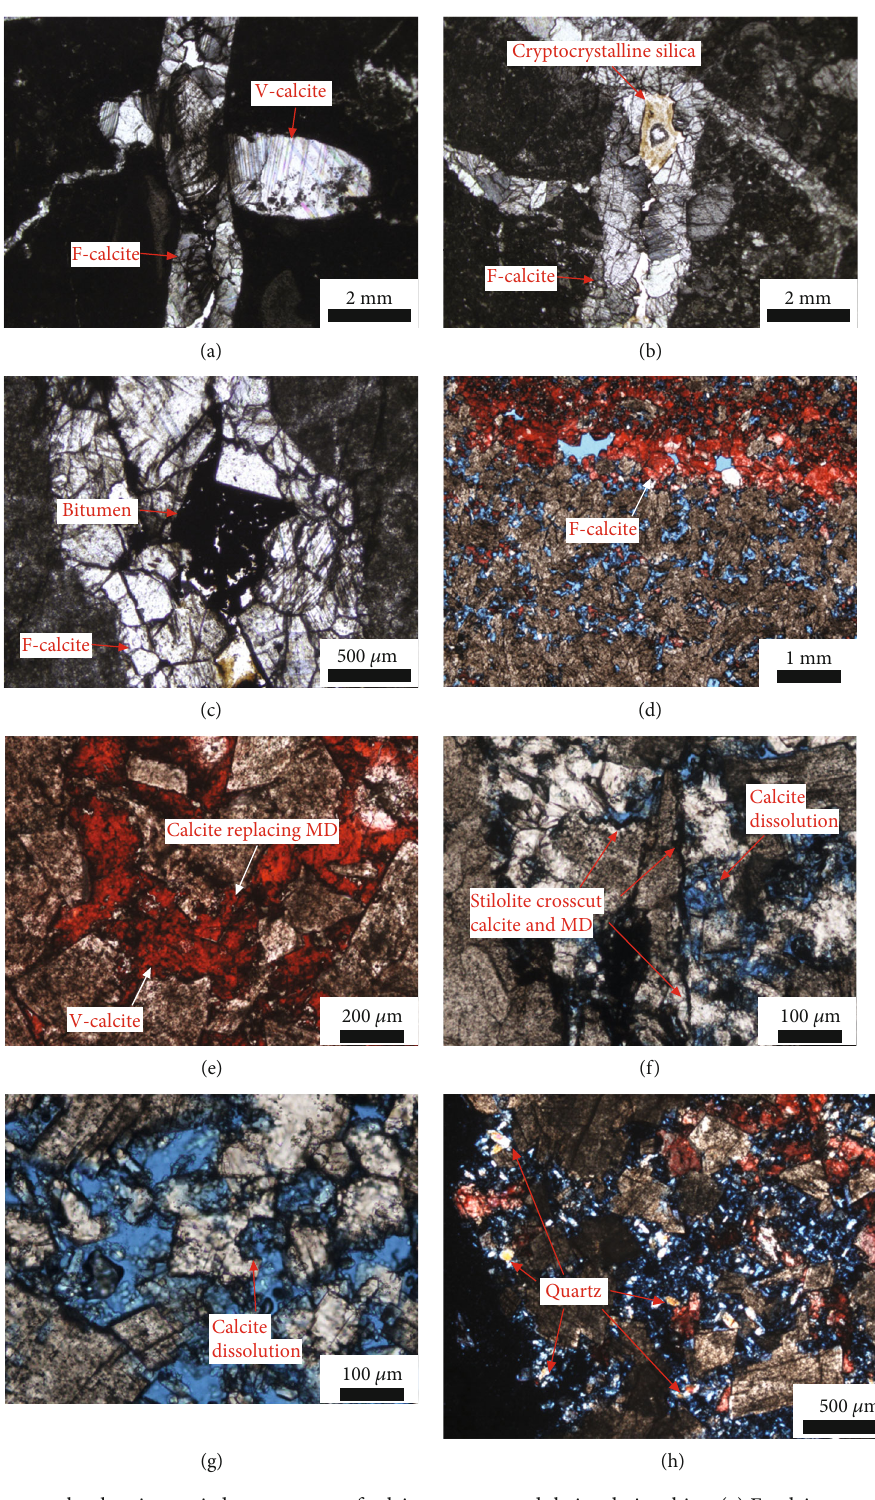
Figure 3: Photomicrographs showing varied occurrences of calcite cements and their relationships. (a) F-calcite crosscutting v-calcite; plane yj ). (b) Cryptocrystalline silica fi lling the rest space left by f-calcite; plane polarized light (SHB5-8-3; polarized light (SHB5-8-1; 7678.6m; O 2 7679.3m; O yj ). (c) Bitumen fi lling the rest space left by f-calcite; plane polarized light (SHB5-8-1; 7679.3m; O yj ). (d) F-calcite and medium- 2 2 crystalline, planar-e dolomites (MD); plane polarized light, blue glue, stained by ARS (SHBP1; 8450.6m; O y ). (e) V-calcite fi lling the 1 − 2 intercrystalline pores of MD and replacing MD; plane polarized light, stained by ARS (SHBp1; 8451.2m; O y ). (f) High-amplitude 1 − 2 y ). (g) V-calcite stylolites crosscutting MD and v-calcite and v-calcite dissolution; plane polarized light, blue glue (SHBp1; 8450.6m; O 1 − 2 y ). (h) Quartz fi lling the intercrystalline pores of MD; crossed dissolution; plane polarized light, blue glue (SHBp1; 8450.6m; O 1 − 2 y polarized light, stained by ARS (SHBP1; 8450.8 m; O 1 − 2